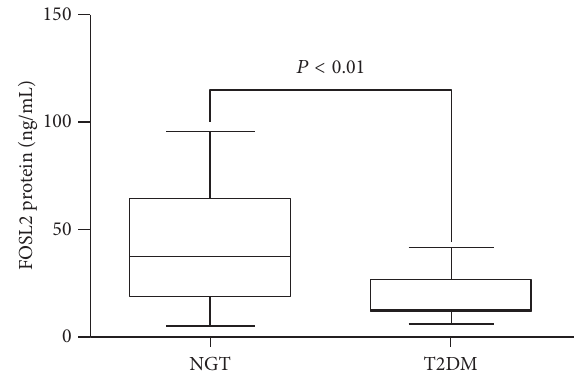
Figure 2: The comparison of the expression levels of FOSL2 protein between the NGT and T2DM groups. Protein was measured by ELISA. Data are presented as the mean ± standard deviation